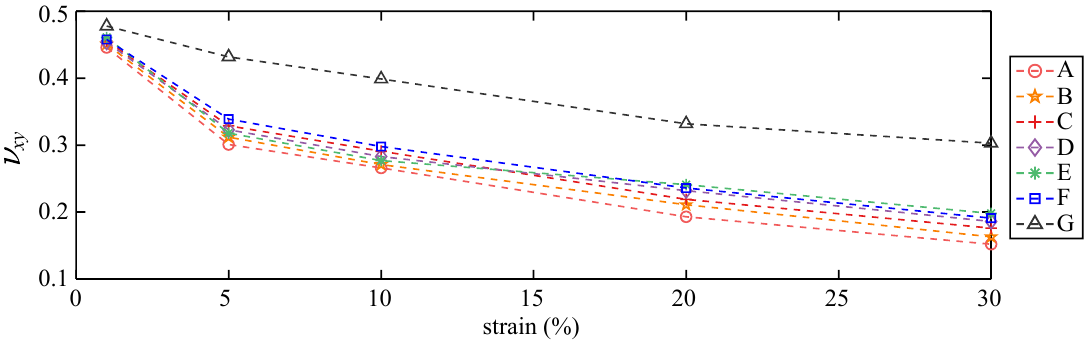
Figure 7. Simulated stress distributions for chosen specimen designs at 10% strain: ( a ) re-entrant hexagonal honeycomb (Pattern A), ( b ) re-entrant triangular-shaped honeycomb (Pattern B), ( c ) re-entrant star system (Pattern C), ( d ) chiral truss (Pattern D), ( e ) zigzag triangular network (Pattern E), ( f ) diagrid-like system (Pattern F), and ( g ) un-textured dielectric (Pattern G).